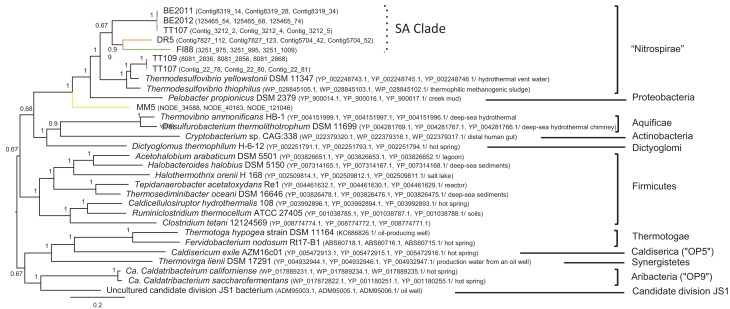
Bayesian likelihood tree of deduced amino acid sequences of the PorC-AB operon. The same color scheme as in Figure 4 is used to highlight our sequences. Our metagenomes are followed by contig IDs, whereas reference taxa are suffixed by GenBank accession numbers and, if available, the source of isolates. Phyla are given to the right of the tree. Nodes are supported by posterior probability and scale bar represents the amino acid substitution rate per site.